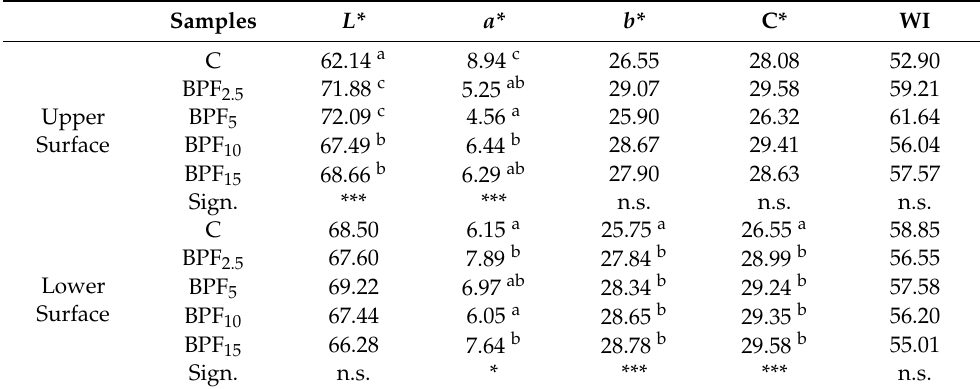
Table 3. Upper and lower surface color of the